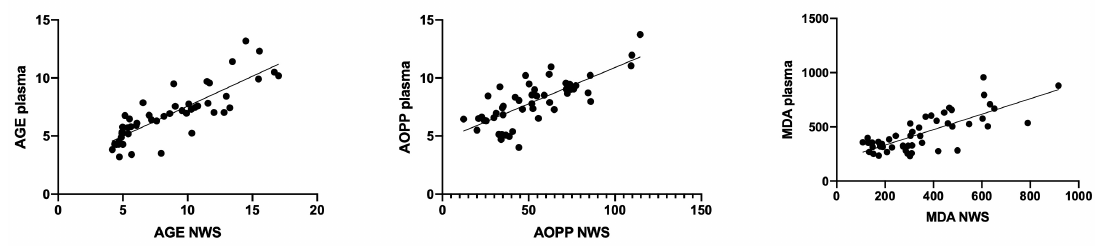
Figure 5. Correlations between salivary and plasma AGE, AOPP, and MDA in patients with heart failure. Abbreviations: AGE—advanced glycation end products; AOPP—advanced oxidation protein products; MDA—malondialdehyde; NWS—non-stimulated whole saliva.